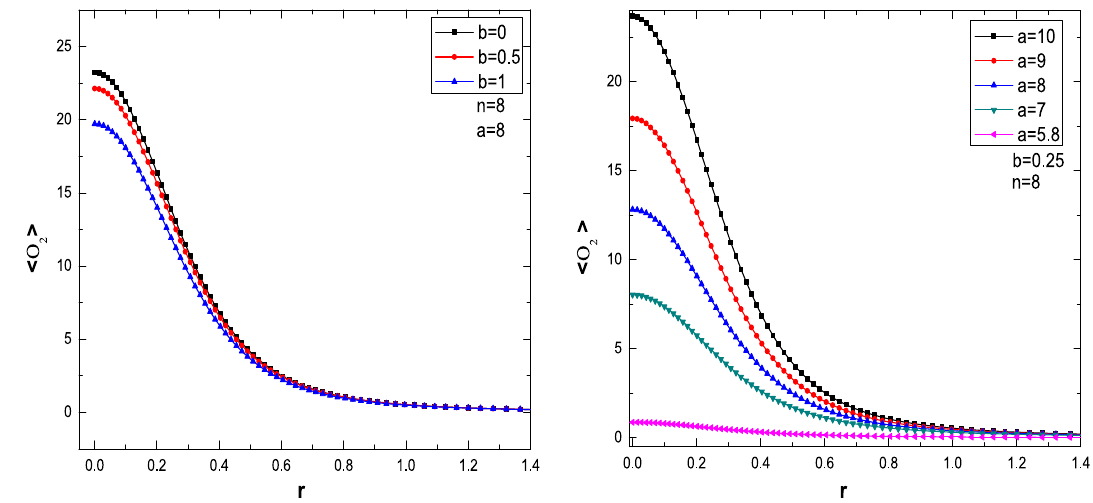
Fig. 3 The condensation as a function of radial coordinate r at conformal boundary with different b (left) and n (right). At both of these two figures we take the value of n = 8 b (cid:2)= 0 is qualitatively similar to that in Maxwell theory with b =